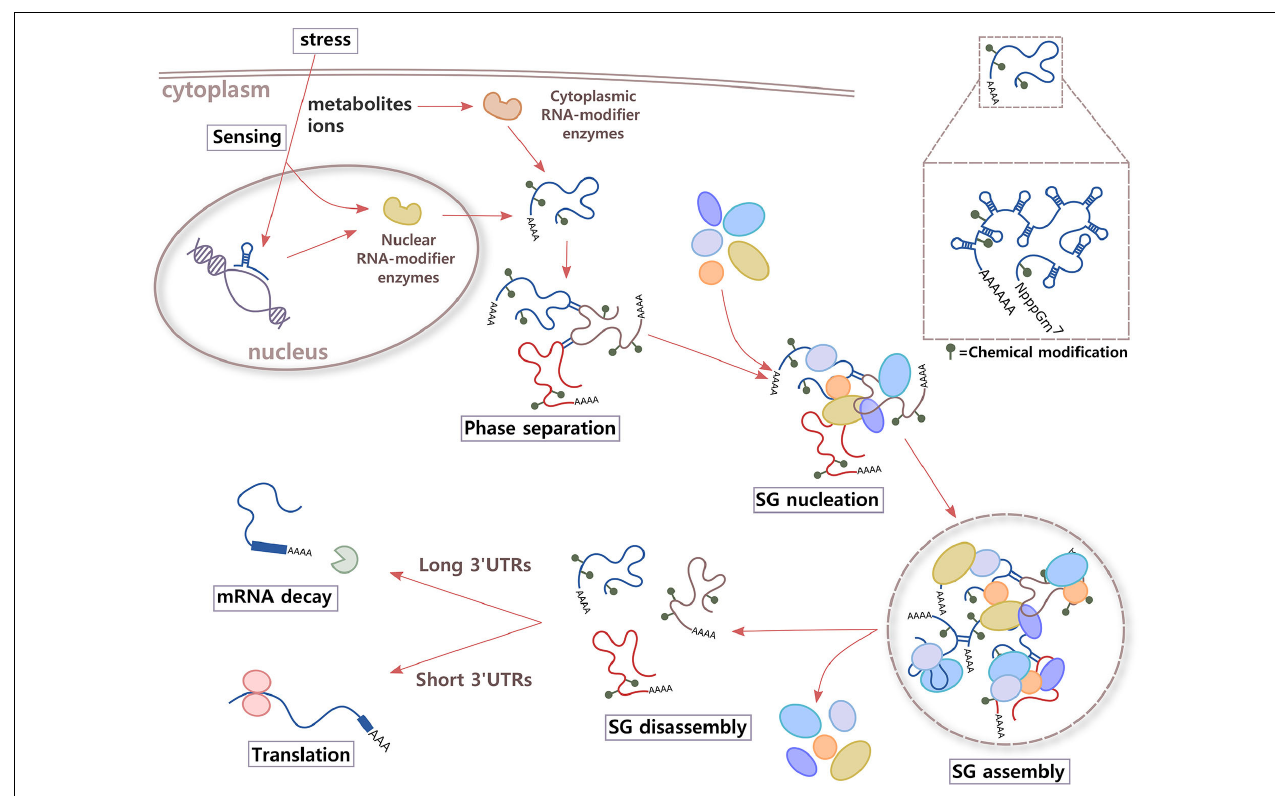
FIGURE 2 | Proposed model. Immediately after integrate stress response (ISR) signaling is activated in the cell, RNA might participate in sensing changes in metabolites and/or ions of the environment through two different mechanisms. Aptamer domains of RNAs that are being transcribed and enzymes that add or erase RNA chemical modifications could bind small molecules whose levels increase inside the cell under stress conditions. As a result, alterations in structure and local charges in RNA in crowded environments of translationally stalled mRNAs could contribute to increase cis and trans RNA–RNA interactions and phase separation. RNA molecules could also work as highly efficient scaffolds for multiprotein complexes through RNA–protein interactions, leading to SG nucleation and assembly. After the stress stimulus disappears, and metabolites and ions return to basal levels, RNA conformation rearrangements could trigger SG disassembly, releasing RBPs and mRNAs. Then, RBPs are re-compartmentalized inside the cell to sites where they exert different functions, and mRNAs are destined to translation (short 3 (cid:48) UTRs) or degradation (long 3 (cid:48) UTRs).